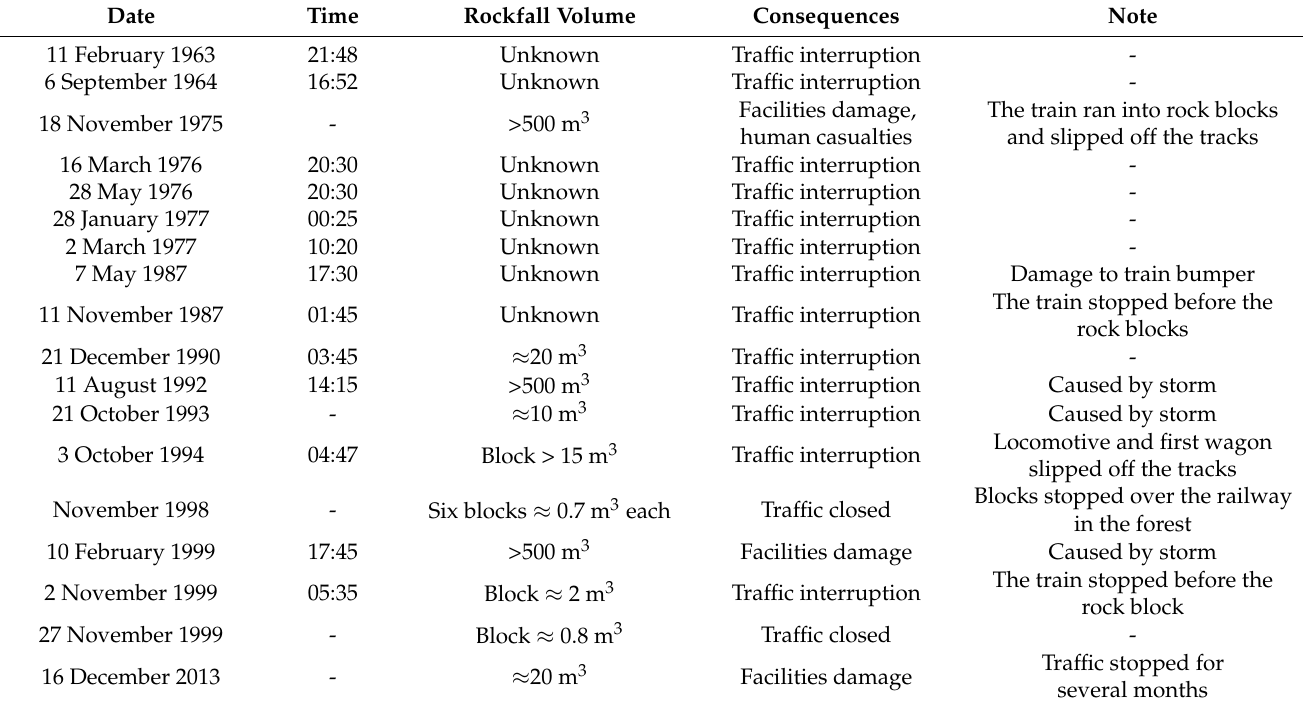
Table 1. The rockfalls registered at the Raspadalica Cliff location by the Croatian Railways Technical